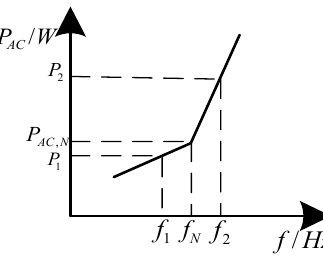
Figure 5. Frequency characteristic of cluster air conditioner.